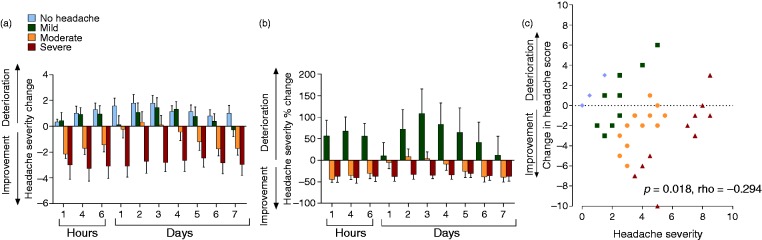
Changes in headache severity score (defined by the numerical rating scale (NRS)) post-LP. (a) Change in headache severity score, data as mean ± SEM; (b) percentage change in headache severity, data as mean ± SEM; (c) correlation of change in headache severity between baseline and 1 hour (y axis) with the mean pre-LP and 1 hour post-LP scores (x axis) using Oldham’s method, p = 0.018, rho = −0.294 (Spearman rank correlation).